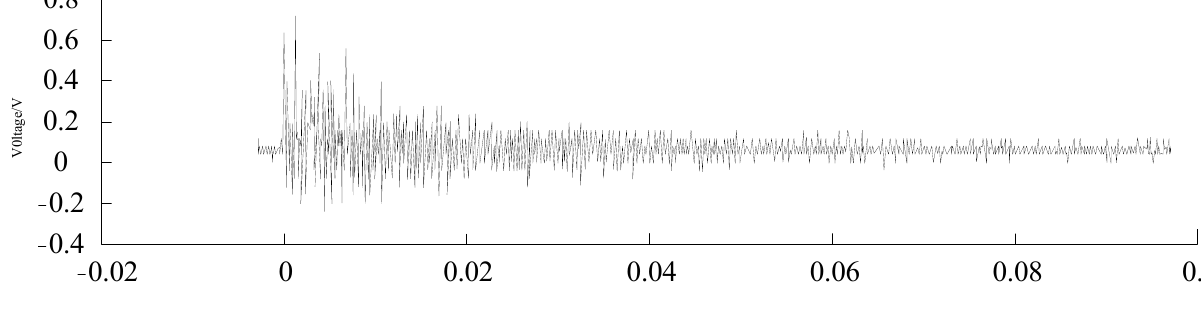
Figure 8. Corn kernel impacting signal after filtering with a cutoff frequency of 8.7 kHz.